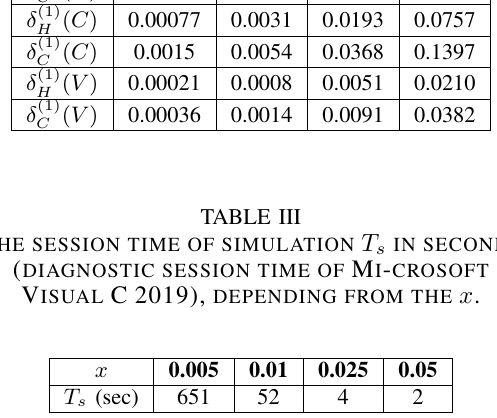
( I ) , - - - graphs of ( I ) , δ (1) C H